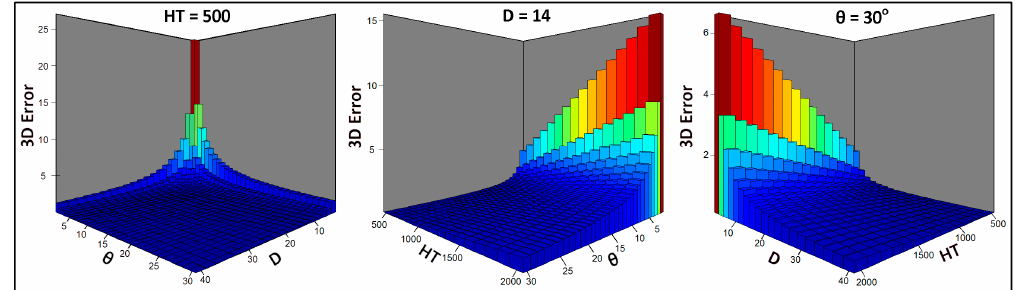
Figure 3. Distribution of 3D error computed using Equation (1) as discrepancy between the location of two intersecting pulses and their closest point of approach calculated after noise is added to the coordinates of returns that define each pulse ray. The error is displayed as function of the above-ground pulse intersection height HT, distance D between the first and last return of each pulse, and angle θ formed between the two originally intersecting pulses. In each of the three panels, one of the three parameters has a fixed value, the other two display their entire value range.